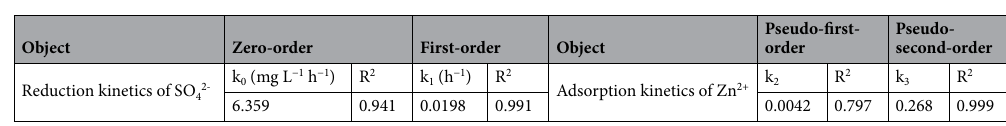
Table. 1. SO 4 2− Zero-order kinetics, first-order kinetics parameters and Zn 2+ pseudo-first-order kinetics, pseudo-second-order kinetics